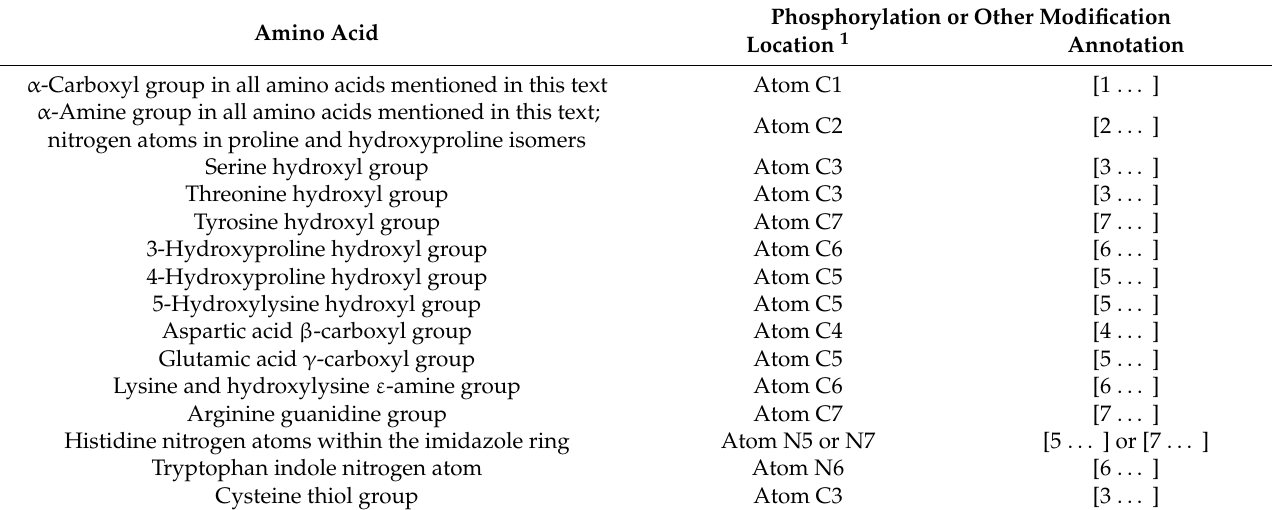
Table 3. Possible location of phosphate groups in amino acid